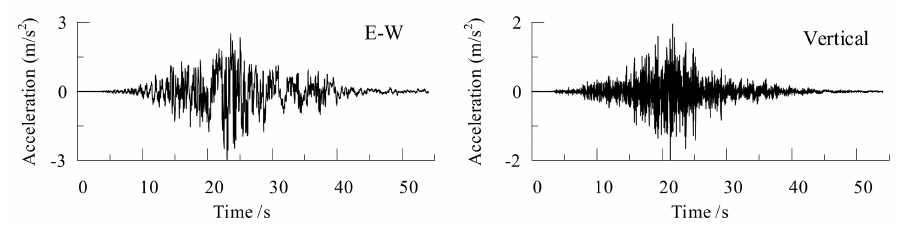
Figure 5. E–W and vertical components of the selected accelerogram A1.